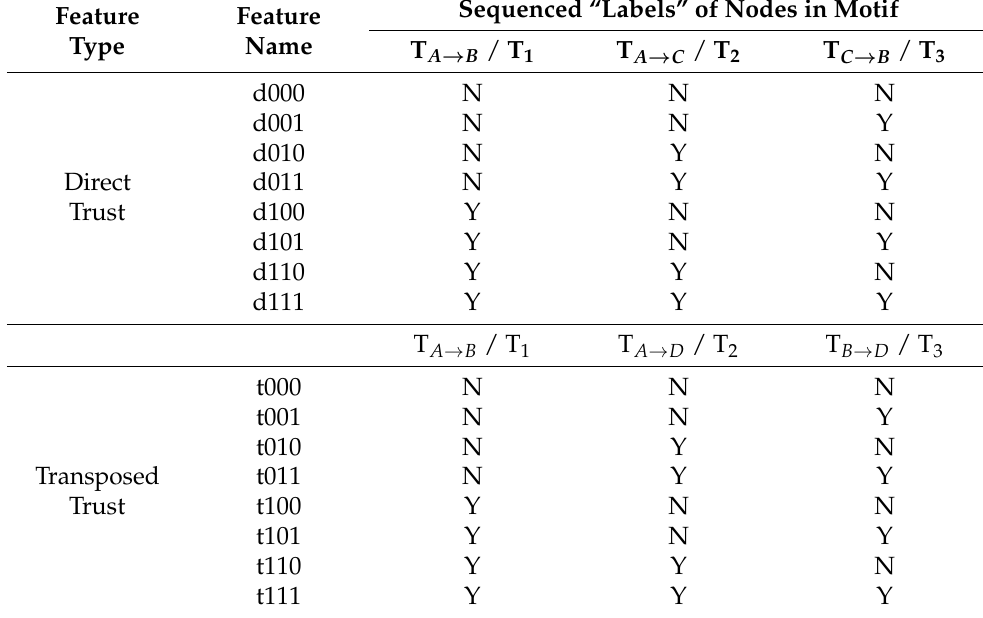
Table 5. Trust propagation features used in the proposed